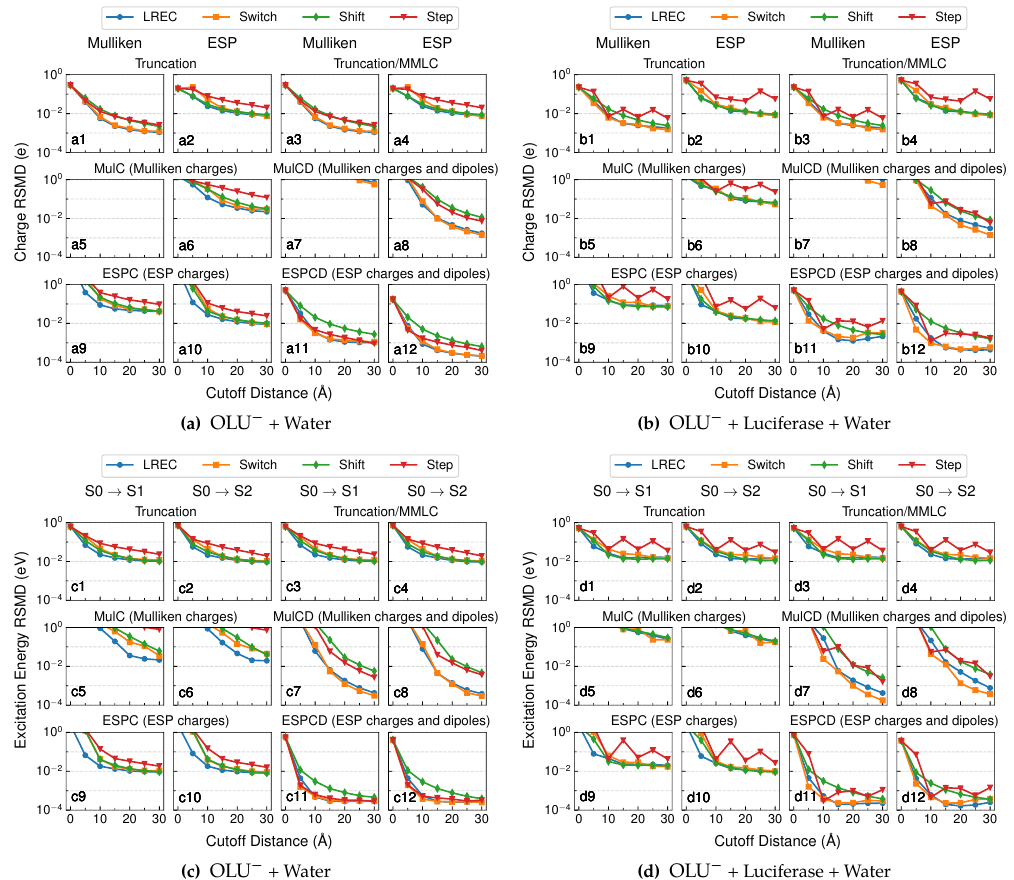
Figure 3. RMSD of Mulliken and ESP charges for the anionic oxyluciferin systems in the ( a ) aqueous and ( b ) enzyme environments; RMSD of excitation energies for the anionic oxyluciferin systems in the ( c ) aqueous and ( d ) enzyme